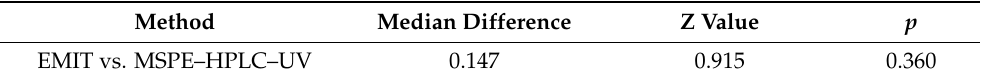
Table 5. Wilcoxon analysis of the MTX plasma concentration by EMIT and